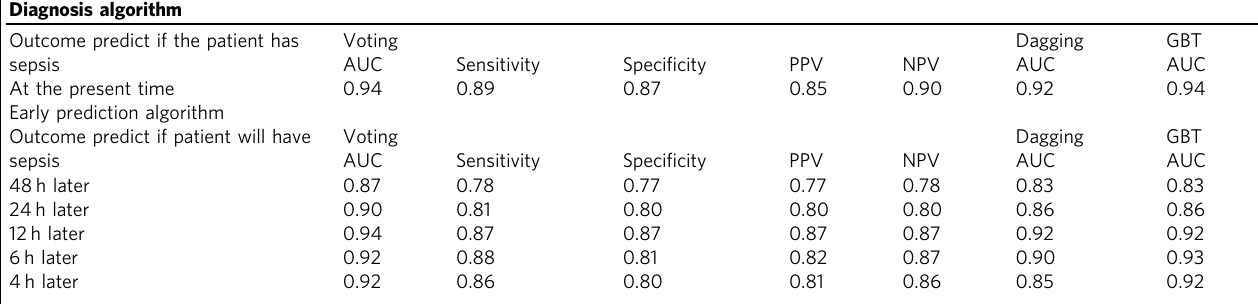
Table 2 Statistics of diagnosis and early prediction algorithm (SMOTE). Diagnosis algorithm Outcome predict if the patient has sepsis